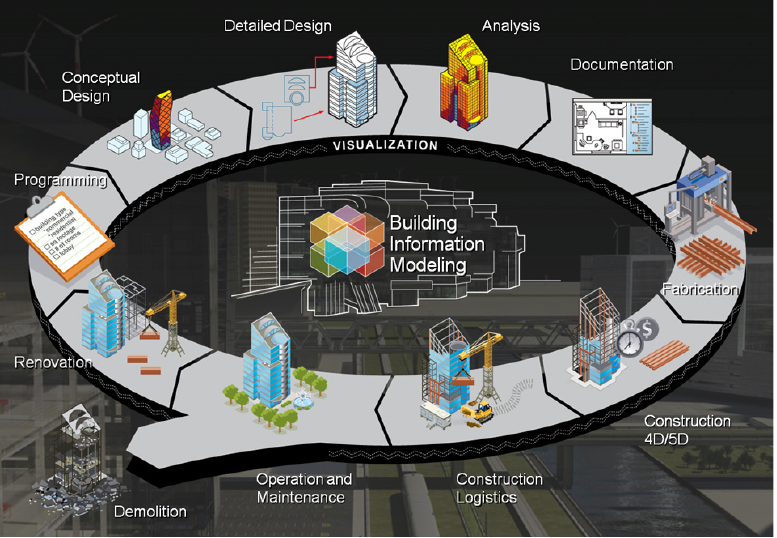
Figure 6. BIM in the life cycle of a construction. Uses (Source: https://www.expanda.es/blog/el-ciclo-de-vida-en-las-infraestructuras/, accessed on 29 July 2019).